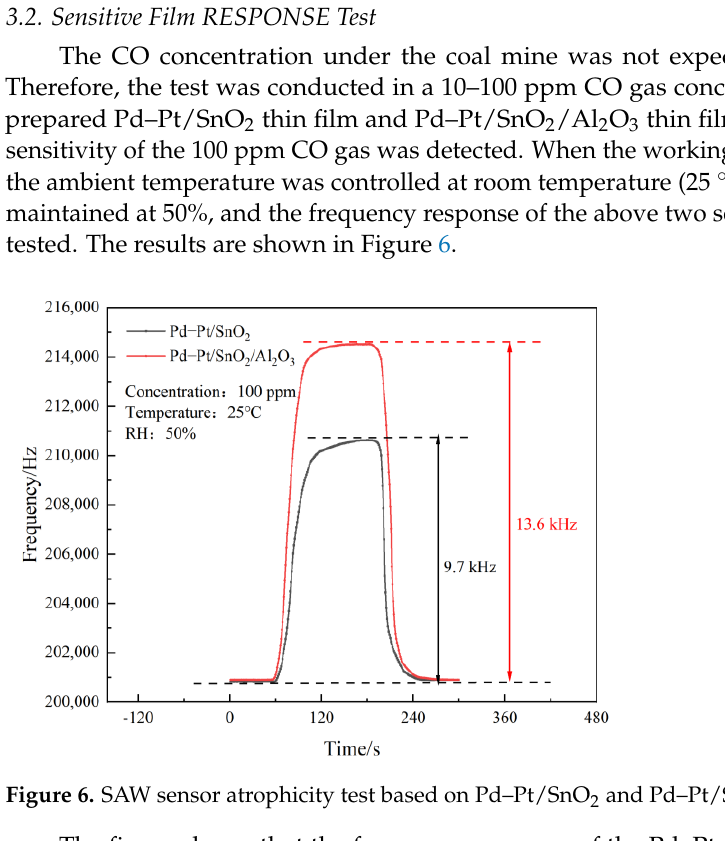
Figure 7. Dynamic response of different CO concentrations of SAW sensors.